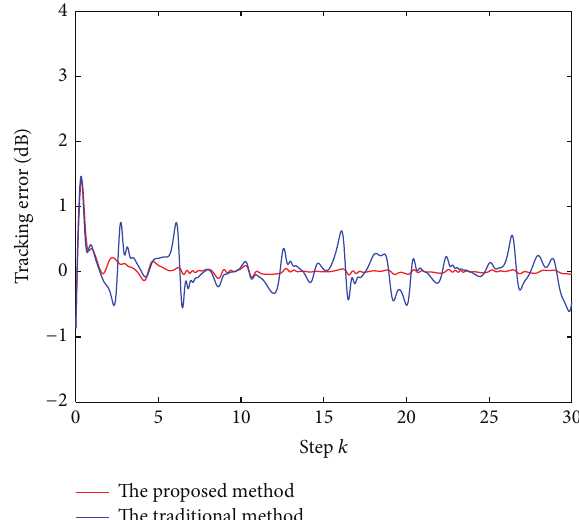
Figure 2: Tracking error between the actual SIR and the target